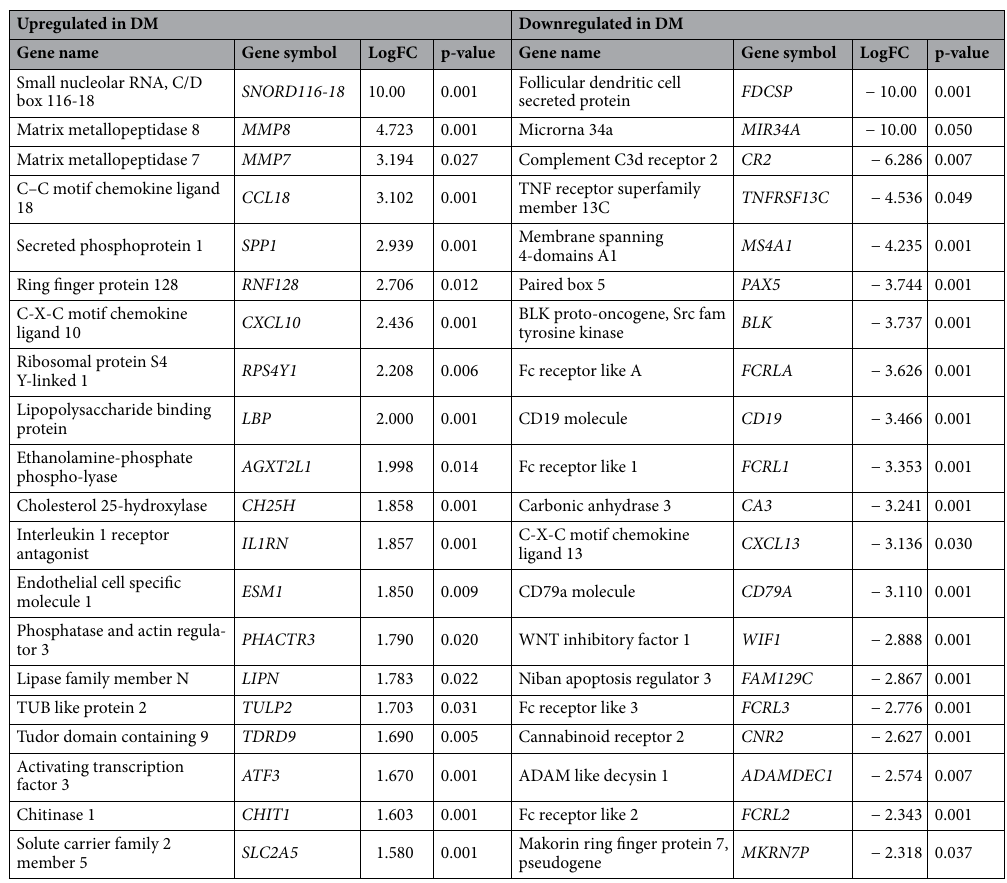
Table 2. Top 20 differentially regulated genes identified by RNA sequencing analysis of human obese VAT comparing DM with NDM patients. Significance represented as negative log (base 10) of p-value.